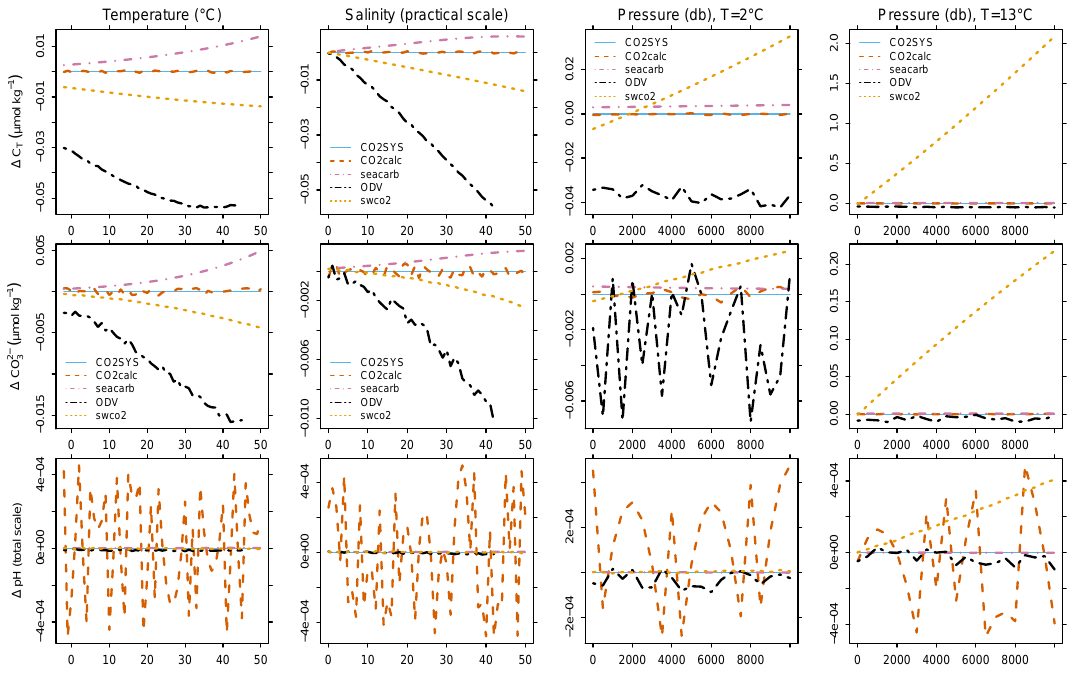
Figure 7. Variables computed from A T and p CO 2 with each package minus corresponding results from CO2SYS-MATLAB. Shown are computed C T (top), CO 2 − (middle), and pH (bottom) across ranges of T (column 1), S (column 2), and P when T = 2 ◦ C (column 3) and 3 when T = 13 ◦ C (column 4) for each package. Packages not included are mocsy, which allows only the A T – C T pair, and csys, which does not allow p CO 2 as an input variable.